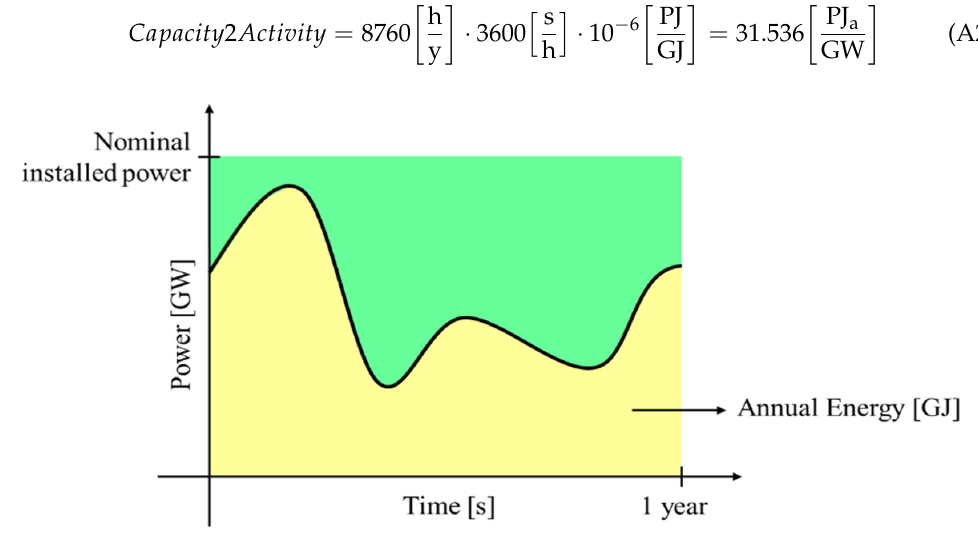
Figure A1. Relation between the nominal power, the actual power and the annual energy produced, for a power sector technology.